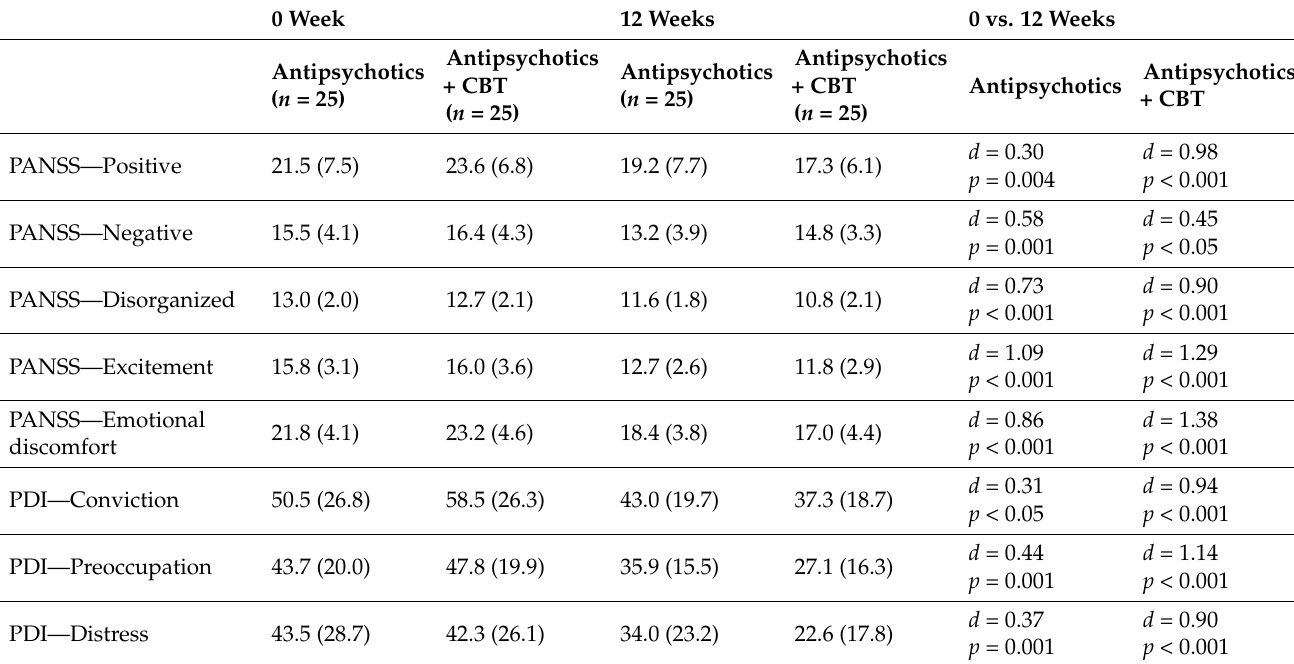
Table 6. Scores on the clinical scales and their comparisons in the schizophrenia groups treated with antipsychotics and antipsychotics plus